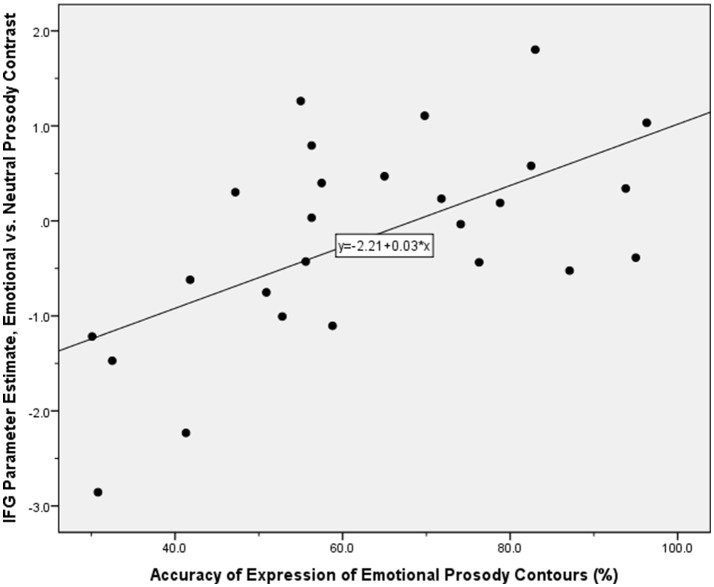
Scatter plot illustrating the correlation between the parameter estimate for the contrast of emotional vs. neutral prosody expression in the inferior frontal gyrus, and the offline index of the accuracy with which participants expressed emotional prosodic contours. Application of the Kolmogorov-Smirnov test for normality indicated that these performance accuracy data were normally distributed: d(26) = 0.091, p > 0.05.